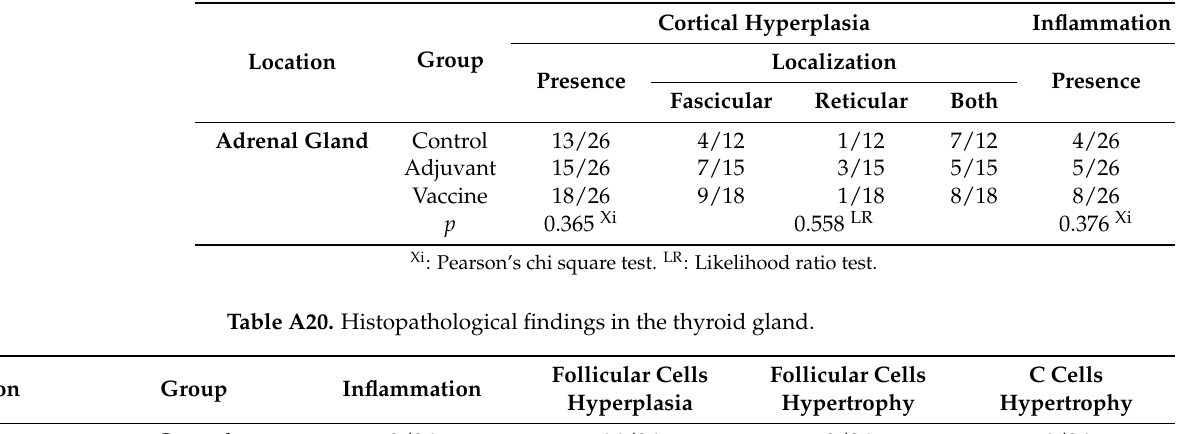
Table A19. Histopathological findings in the adrenal gland.